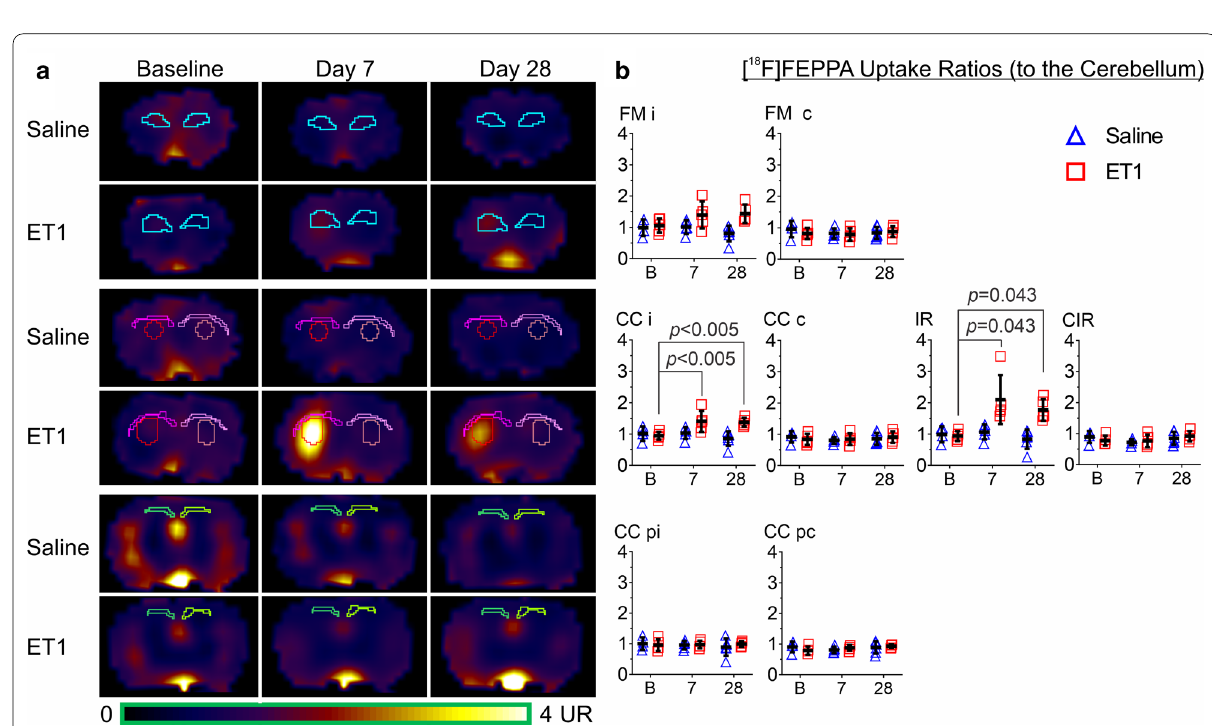
Fig. 3 [ 18 F]FEPPA UR was not elevated in remote WM following ET1‑induced stroke. a Maps and b values of longitudinal [ 18 F]FEPPA PET uptake ratio, relative to the cerebellum, revealed a significant region‑ET1‑timepoint interaction in saline and ET1 rats [ F (20,120) ANOVA]. c, contralateral; CC, corpus callosum; CIR, contralateral to the infarct region; FM, Forceps Minor; i, ipsilateral; IR. infarct region p,